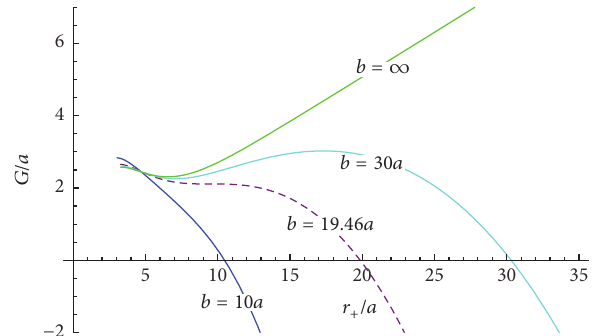
Figure 9: Plot of the Gibbs free energy 𝐺 with respect to 𝑟 + under differentpressure.Thegreen,cyan,andbluesolidcurvescorrespond to the different cases of ( 𝑏/𝑎 , 𝐺(𝑟 0 )/𝑎 ): ( ∞ , 2.575), (30, 2.607), and (10, 2.835), respectively. The dashed purple curve corresponds to the critical vacuum pressure with (19.46,